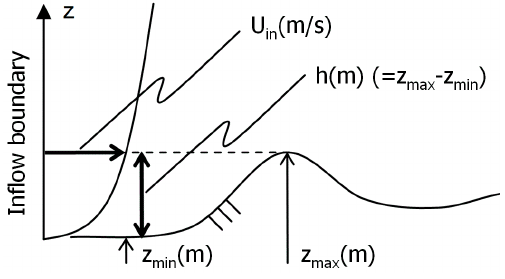
Figure 5. Characteristic velocity and length scales (U in and h).